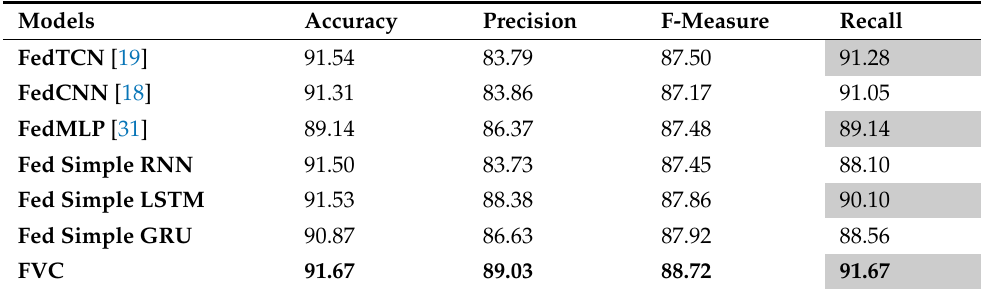
Table 5. Comparison of previous literature with FVC in terms of accuracy, precision, F-measure, and recall.